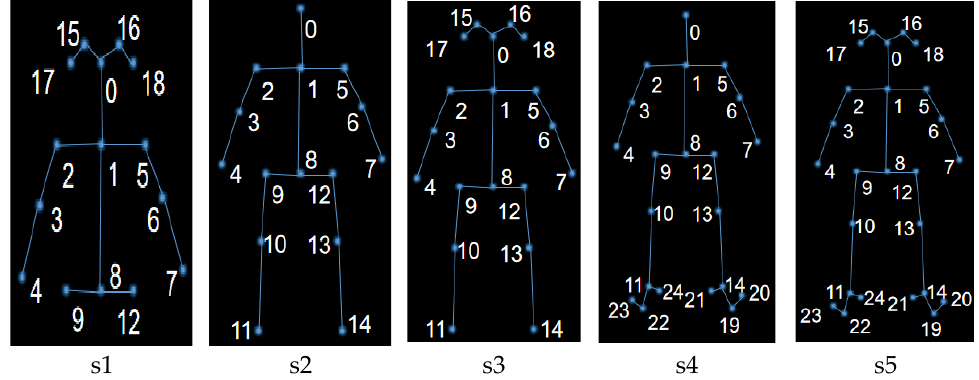
Figure 10. Human skeleton diagram corresponding to the different number of selected skeletal points. s1: n = 15 (upper body); s2: n = 15; s3: n = 18; s4: n = 21; s5: n = 25.